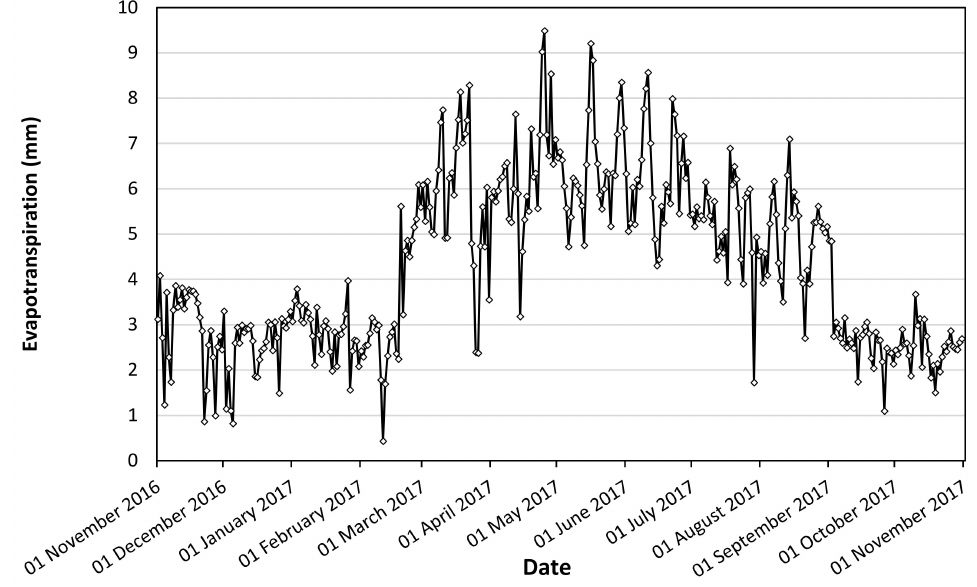
Figure 1. Pattern of daily reference crop evapotranspiration during the clementine crop